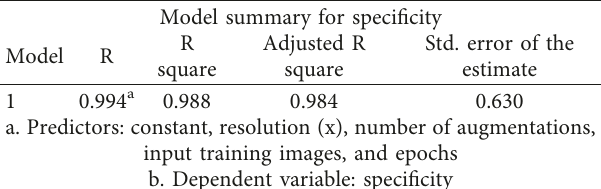
Table 4: Model summary output for